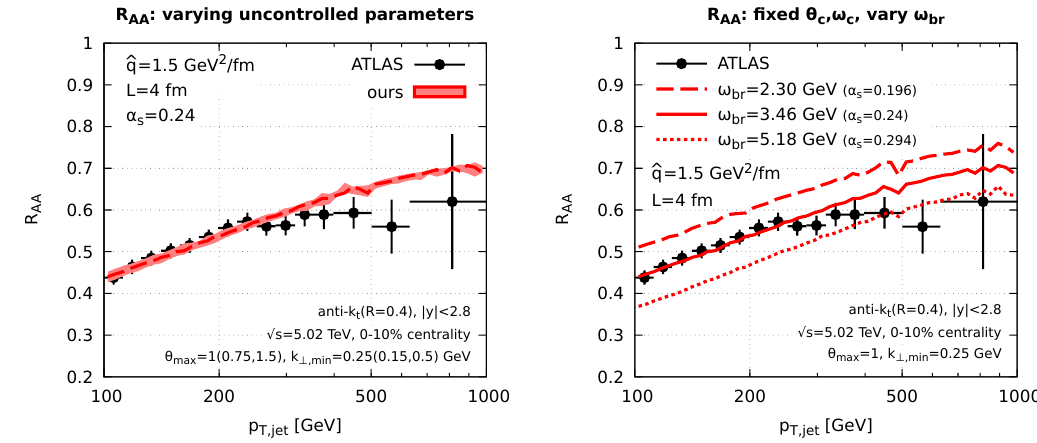
Figure 6 . Our MC predictions for R AA are compared with the results of an experimental analysis by ATLAS [30] (shown as dots with error bars). Left: the sensitivity of our results to changes in the kinematic cuts (cid:18) max and k ? ; min . Right: the e(cid:11)ect of varying ! br (by (cid:6) 50%) at (cid:12)xed values for ! c and (cid:18) c .